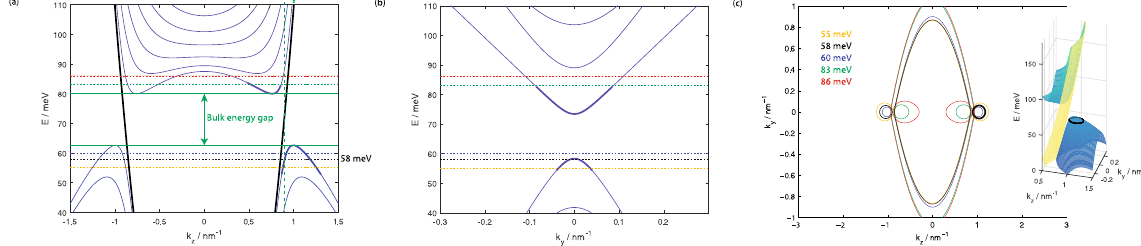
Figure 1. Panel (a) shows the dispersion relations at k y = 0 for a 50 nm thick Na 3 Bi thin film. The bands in black correspond to the Fermi arc states. Each horizontal dotted line corresponds to the energy of the Equal Energy Contour (EECs) of the same colour in panel (c). The vertical dotted line denotes k z = 0.9 nm − 1 , the value of k z panel the k y dispersion relations in panel (b) are plotted at. Panel (b) shows the dispersion relations at k z = 0.9 nm − 1 . Panel (c) shows the EECs for the same thin film at various values of energy indicated in the figure legend. The inset shows the three-dimensional plot of the gapped Dirac with positive k z with the black ring around the hole like states of the cone depicting the source states whose transmission we will study in this paper. The yellow sheet between the upper and lower cones corresponds to the Fermi arc